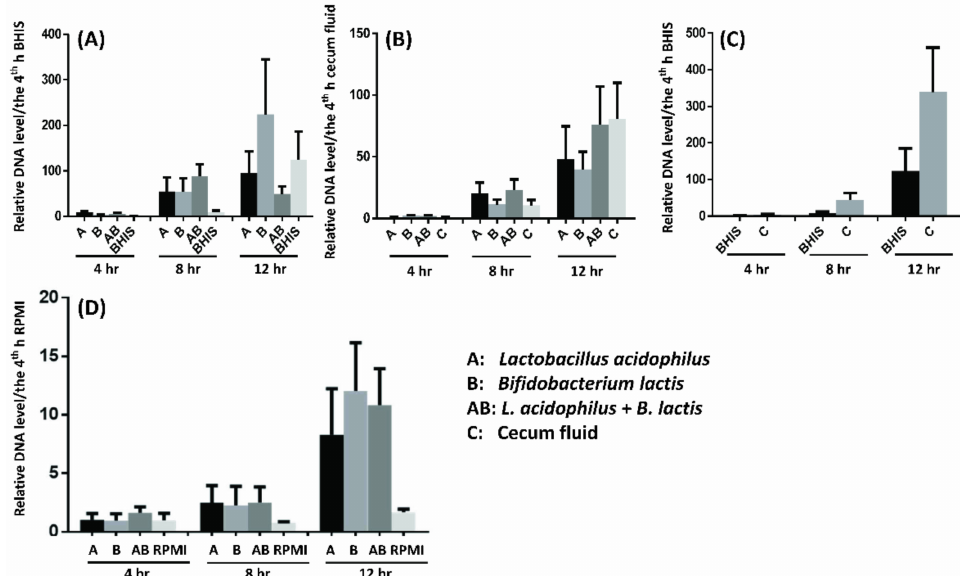
Figure 4. Lactobacillus acidophilus and Bifidobacterium lactis promote F. prausnitzii growth in vitro and in ex vivo. All relative DNA level were calculated by tested value / the 4th h control value. The L. acidophilus and B. lactis were sub-cultured in BHIS broth and incubated until the bacterial density reached OD ≥ 0.5 (5 × 10 7 / µ L). Then 100 µ L of culture media was added in 5 mL RPMI-1640 ( A ) or 20 µ L in 1 mL cecum fluid ( B ) and incubated for 24 h. After filtration, 100 µ L of supernatant was added in 30 mL YCFA broth with F. prausnitzii (APC 918 / 95b) co-cultured for 4, 8, and 12 h. ( C ) F. prausnitzii cultured in YCFA with BHIS or cecum fluid only. ( D ) The equal-sized cecum tissue was co-cultured with 3 mL RPMI medium with or without L. acidophilus and B. lactis for 24 h. The 100 µ L supernatants was added in 30 mL YCFA broth with F. prausnitzii co-cultured for 4, 8, and 12 h. The relative abundance of F. prausnitzii were measured as the percentage of total bacteria DNA copy numbers by real-time PCR. All tests were triplet.